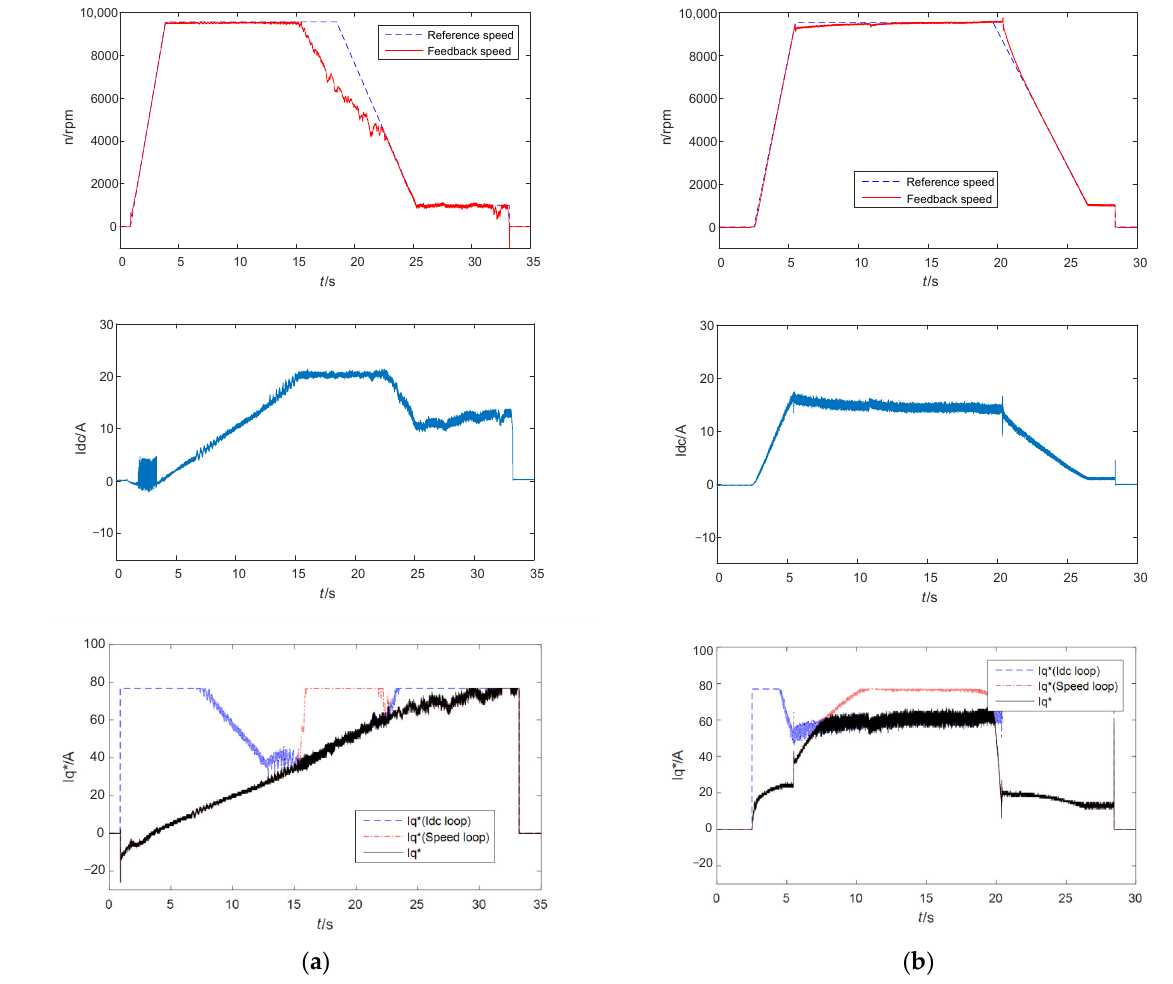
Figure 12. ( a ) Speed, power current, and I q ∗ test curve with load at 25 ◦ C and ( b ) without load at − 50 °C.